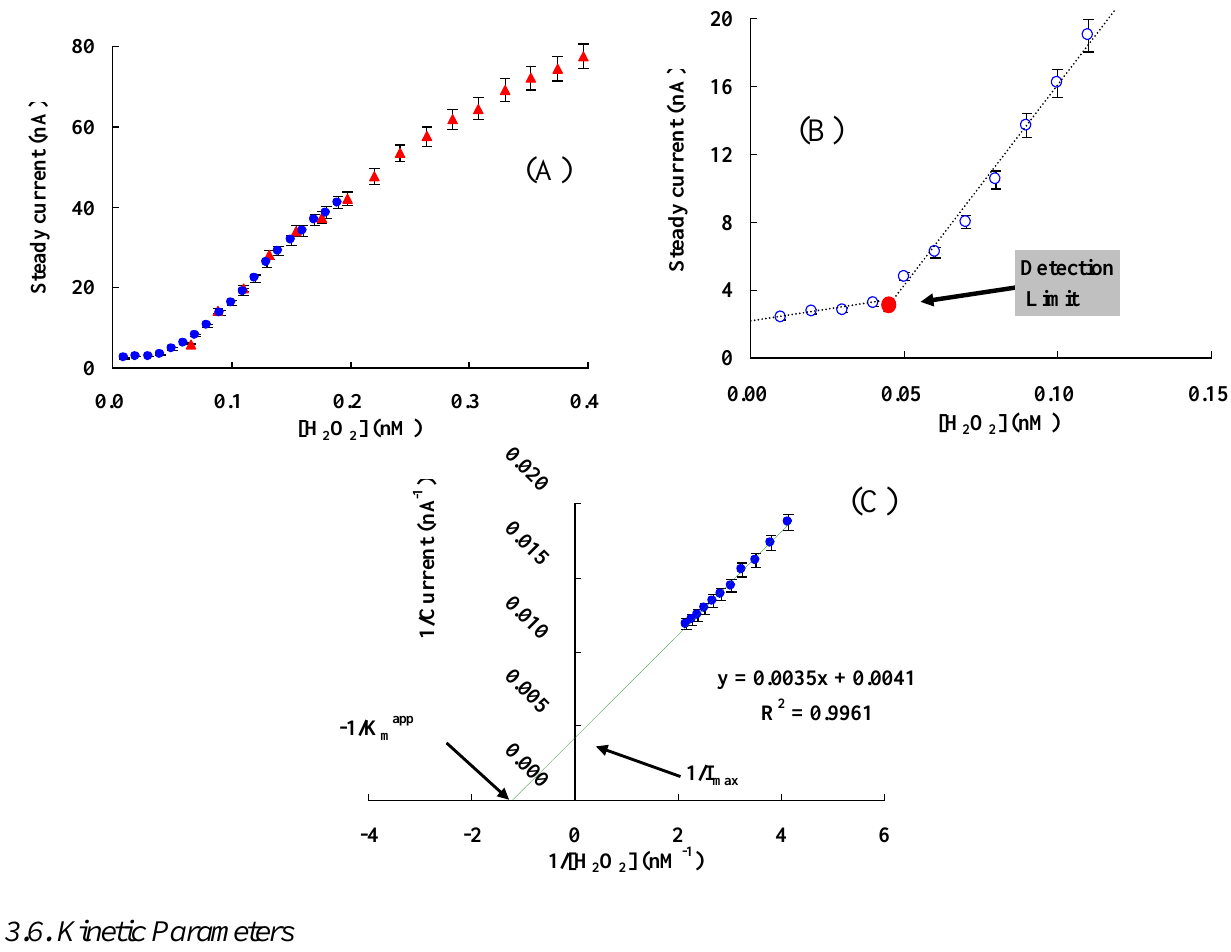
Figure 6. ( A ) The typical steady current vs. [H of 5 μL of 10 nM (●) and 20 nM (▲) H potential of −0.35 V ( vs . Ag/AgCl). ( B ) The determination of the H NF/Hb/FMWCNTs/Cys/AuNPs/GC electrode. The detection limit was determined from the cross point of the lines fitted to the linear segments of the steady current Is vs. [H in the process of successive additions of 5 μL of 10 nM H (pH7.0). ( C ) Lineweaver-Burk plot for K mapp